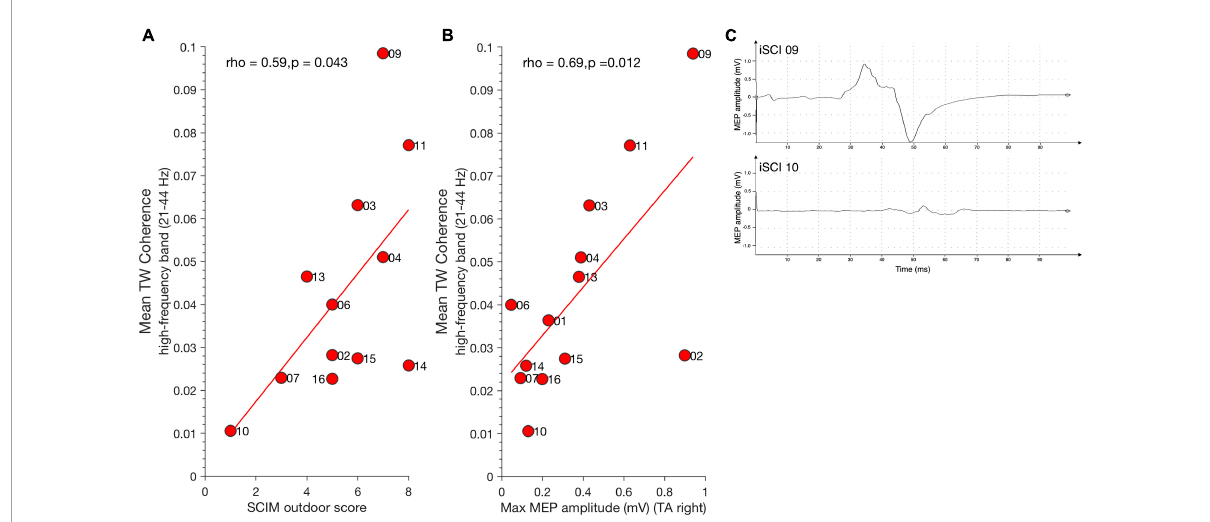
FIGURE3 Relationship between high-frequency coherence and clinical parameters. (A) Mean SCIM outdoor mobility score positively correlates with high-frequency coherence during TW. (B) Maximum MEP amplitude of Tibialis anterior muscle (TA) positively correlates with high-frequency coherence during TW. Dots represent individuals with iSCI and their ID. (C) Examples for MEP traces of iSCI 09 (top) who has a high MEP amplitude and high mean high-frequency coherence value and iSCI 10 (bottom) who has low a MEP amplitude and low mean high-frequency coherence value. iSCI, incomplete spinal cord injury; MEP, magnetic evoked potential; SCIM, spinal cord Independence measure; TAp, Tibialis anterior proximal; TAd, Tibialis anterior distal; TA, Tibialis anterior muscle; TW, Target walking.